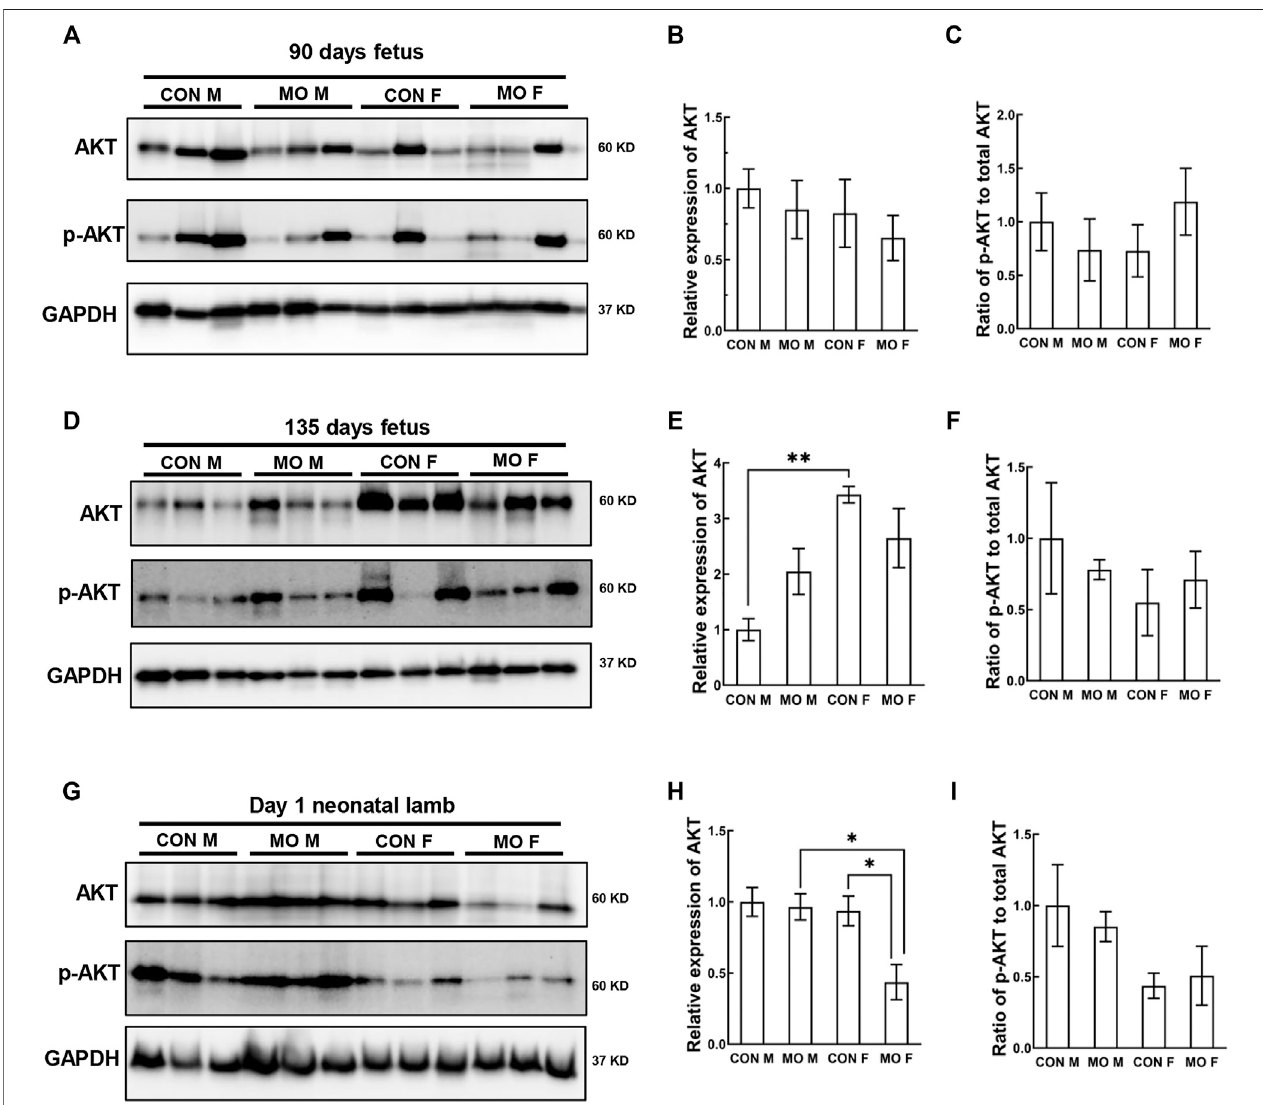
FIGURE2| Alteration ofAKT signaling pathway inoffspringheartofoverfed ewes at twogestationaland one earlypostnatal time point. (A – C) . Relative expression and phosphorylation level of the kinase Akt in fetal heart at mid-gestation day 90; (D – F) . Relative expression and phosphorylation level of the kinase Akt in fetal heart at late-gestationday135; (G – I) .RelativeexpressionandphosphorylationlevelofthekinaseAktinneonatalheartatday1afterbirth;GAPDH,Proteinloadingcontrol.CON, control, MO, maternal obesity, M, male, and F, female. Mean ± SEM ( n (cid:1) 5); * p < 0.05, ** p < 0.01.